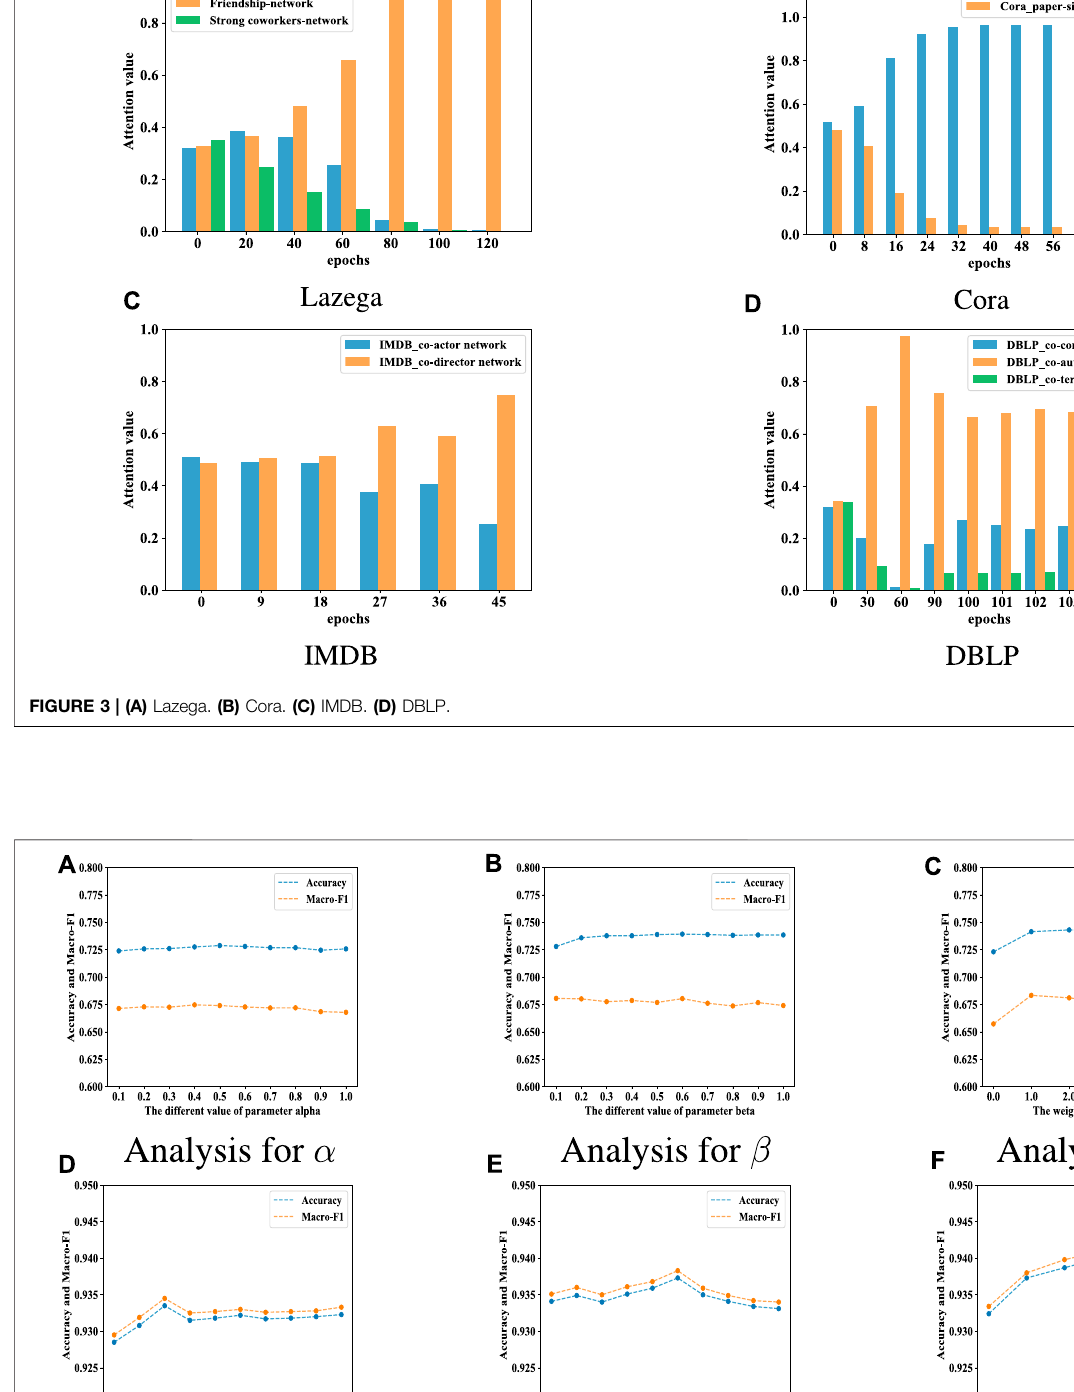
Frontiers in Physics |